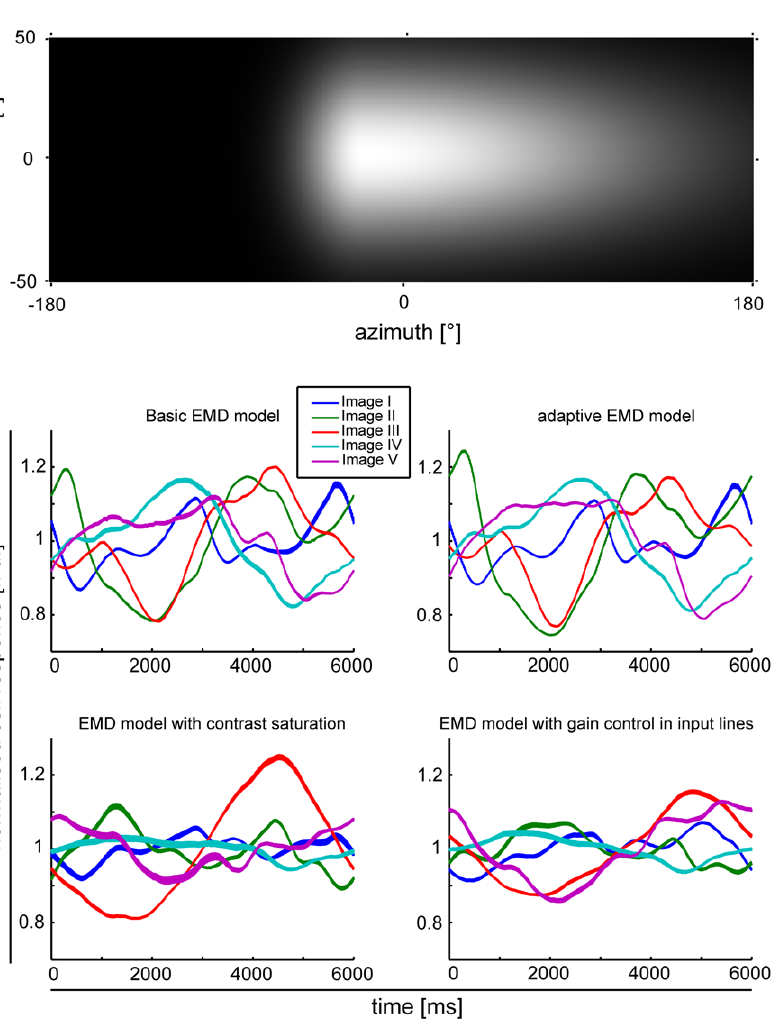
Figure 7. EMD array responses with an estimated HSE cell receptive field. (A) Weight field estimate of the spatial sensitivity distribution of a model HSE cell. The brighter the gray level the larger the local weight of the corresponding EMDs and, thus, the spatial sensitivity. The frontal equatorial viewing direction is at 0 u azimuth and 0 u elevation. (B) Normalized response traces of HSE models with the four types of EMD variants as indicated in the figure. Image motion was performed for 12s in preferred direction with an angular velocity of 60 u /s. Responses to all image datasets are shown.